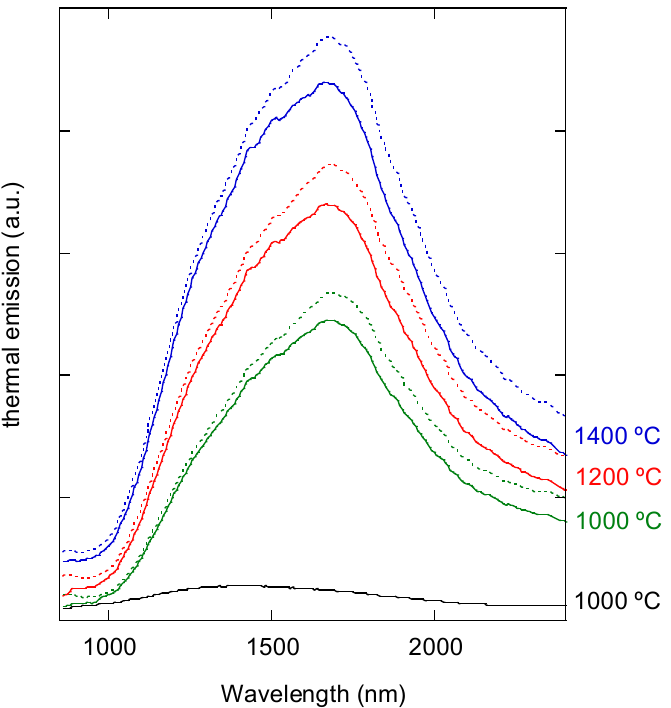
Figure 2. Thermal emission spectra of Co0.12-50 (solid lines) and Co0.15-750 (dotted lines) eutectic rods measured at 1000, 1200 and 1400 °C. Black solid line shows the emission measured in the undoped MgO-MgSZ eutectic rod at 1000 °C.